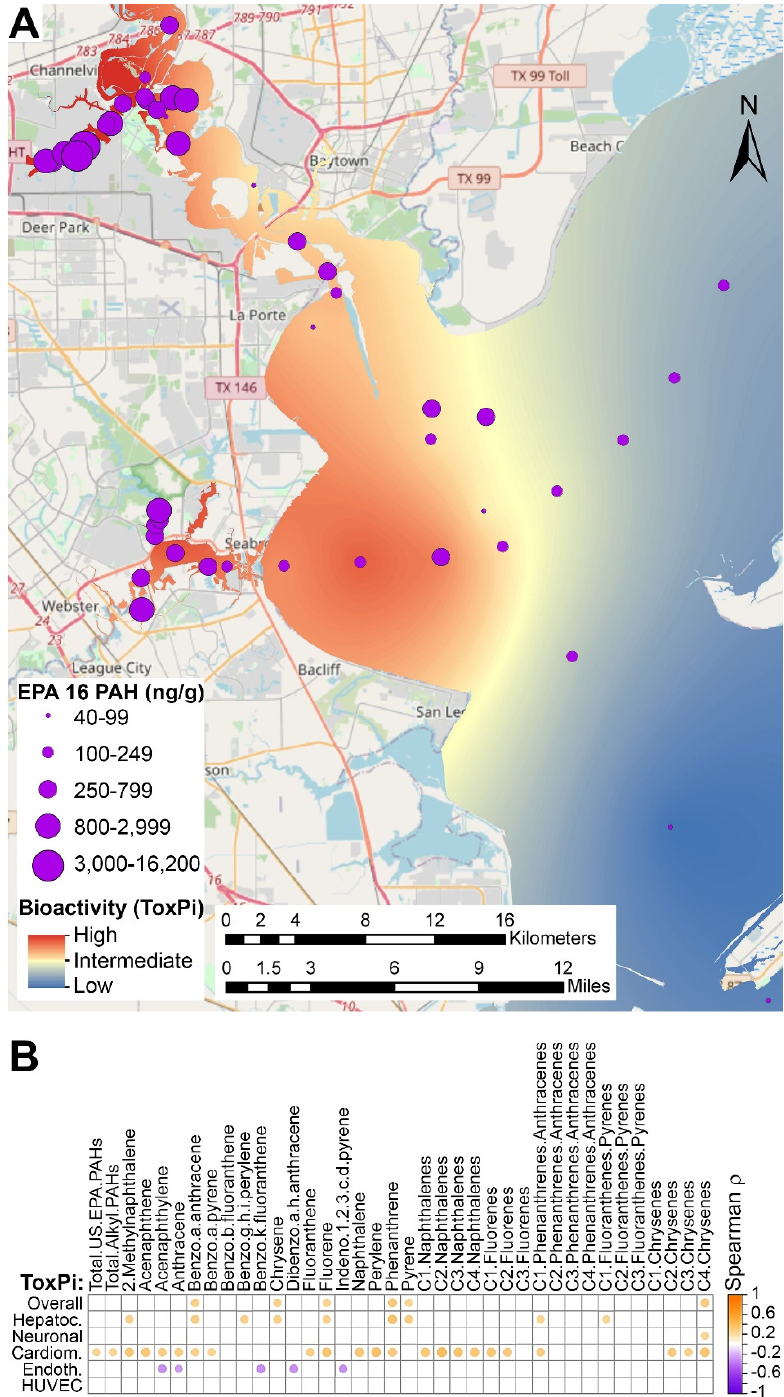
Figure 4. Correlation analysis between bioactivity and PAH content of the sediment samples. (A) Interpolation of the spatial patterns in bioactivity of samples based on all phenotypes from iCell cardiomyocytes. ToxPi values for this cell type were used to create the map that visualize bioactivity as a color gradient (red = highest, blue = lowest; see the legend inset for color gradient). Sampling locations are identified as purple dots and the cumulative concentration of 16 EPA priority PAH were used to scale each dot (see the legend inset for scaling). (B) Spearman correlation of all PAHs with total bioactivity in each cell type. Significant ( p adj < 0.05) correlations are shown as dots that are colored based on the p value as indicated in the color bar.